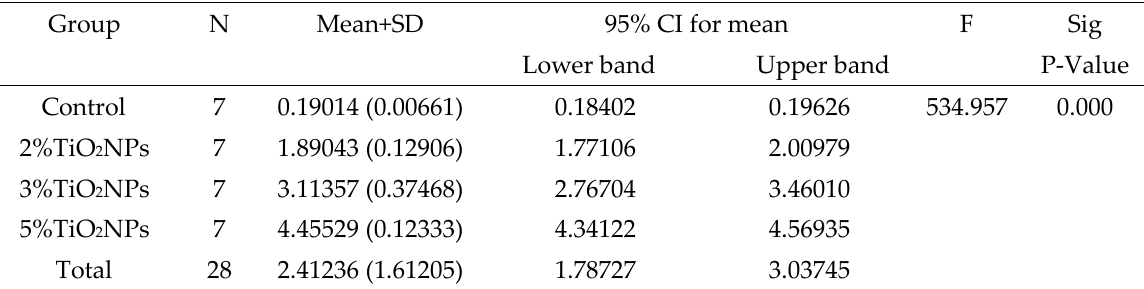
Table 1: One-way ANOVA test for S.mutans